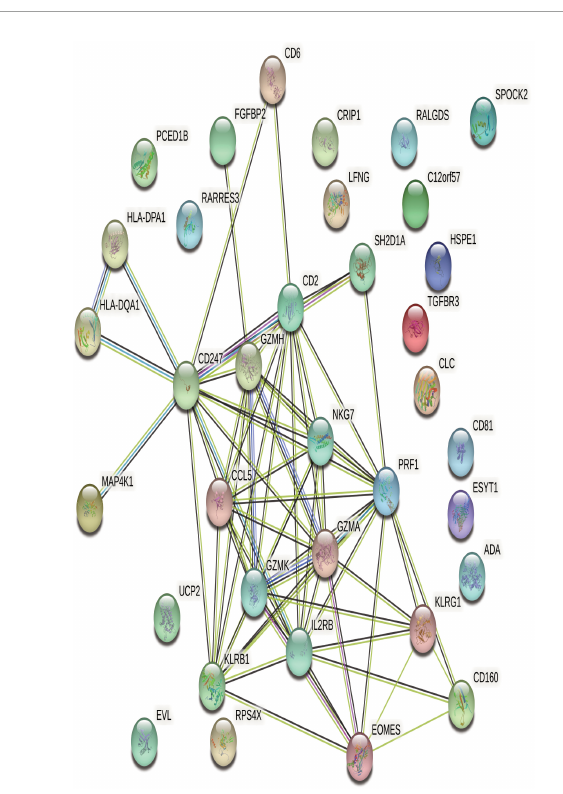
FIGURE3 STRING network of protein-protein interactions (PPI) of differentially expressed genes (DEGs) related to AMI. In PPI networks, there are seven different colored lines: 1. Light blue: supported by the evidence from database; 2. Purple: experimentally proved; 3. Red: gene-gene fusion; 4. Yellow-green: supported by the evidence from previous studies; 5. Green: genetic proximity; 6. Blue: co-existing genes; 7. Black: co-expression between genes. Filled nodes indicate the proteins which have their three-dimensional structure known or predicted, while empty nodes designate those whose three-dimensional structures are yet to be resolved.